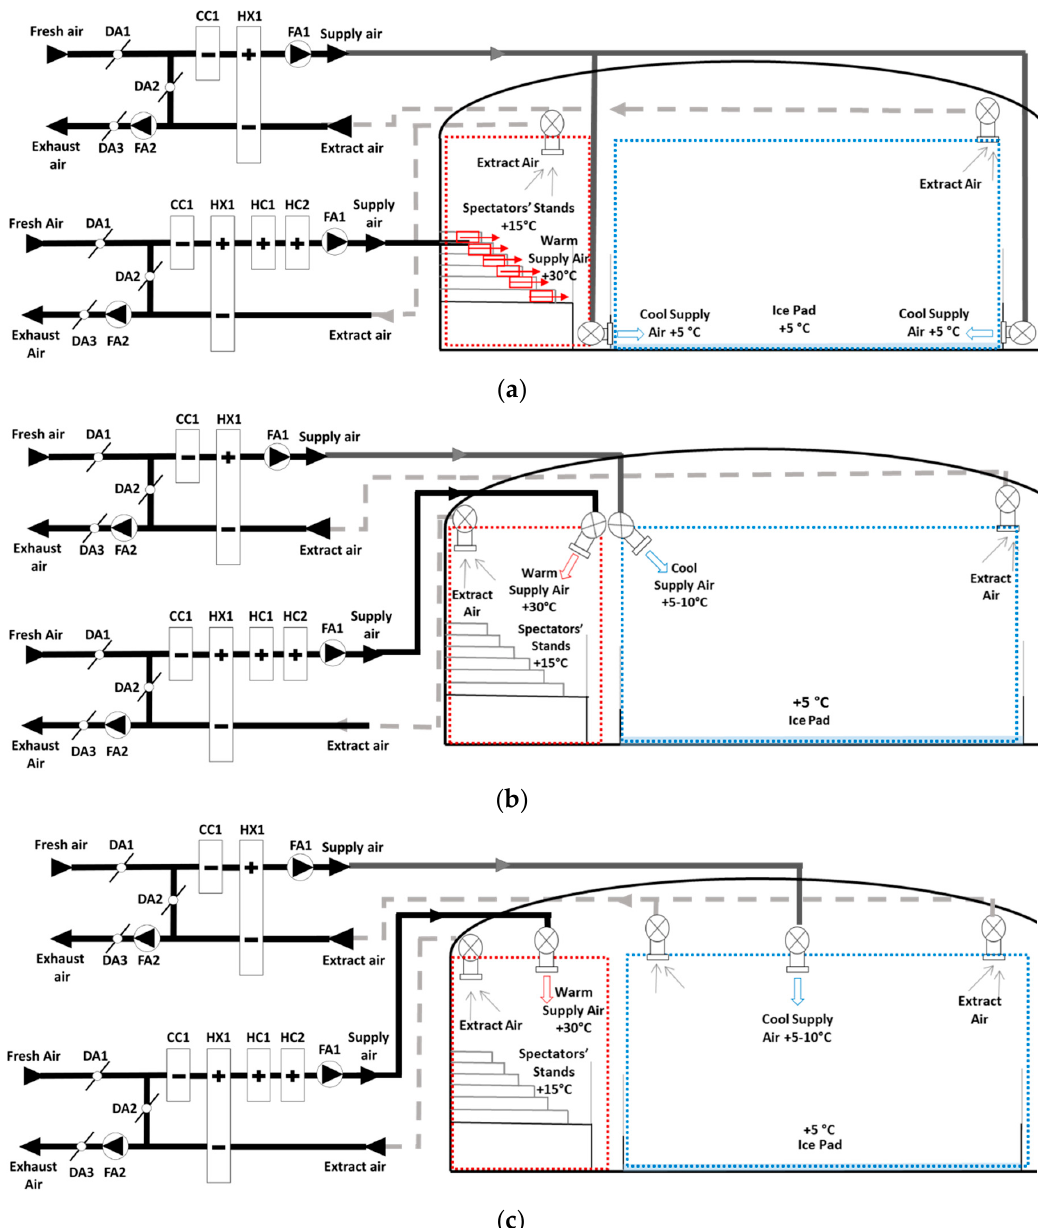
Figure 18. Proposed air distribution strategies to reduce the indoor temperature gradient. ( a ) Horizontal supply air; ( b ) inclined supply air; ( c ) vertical supply air.